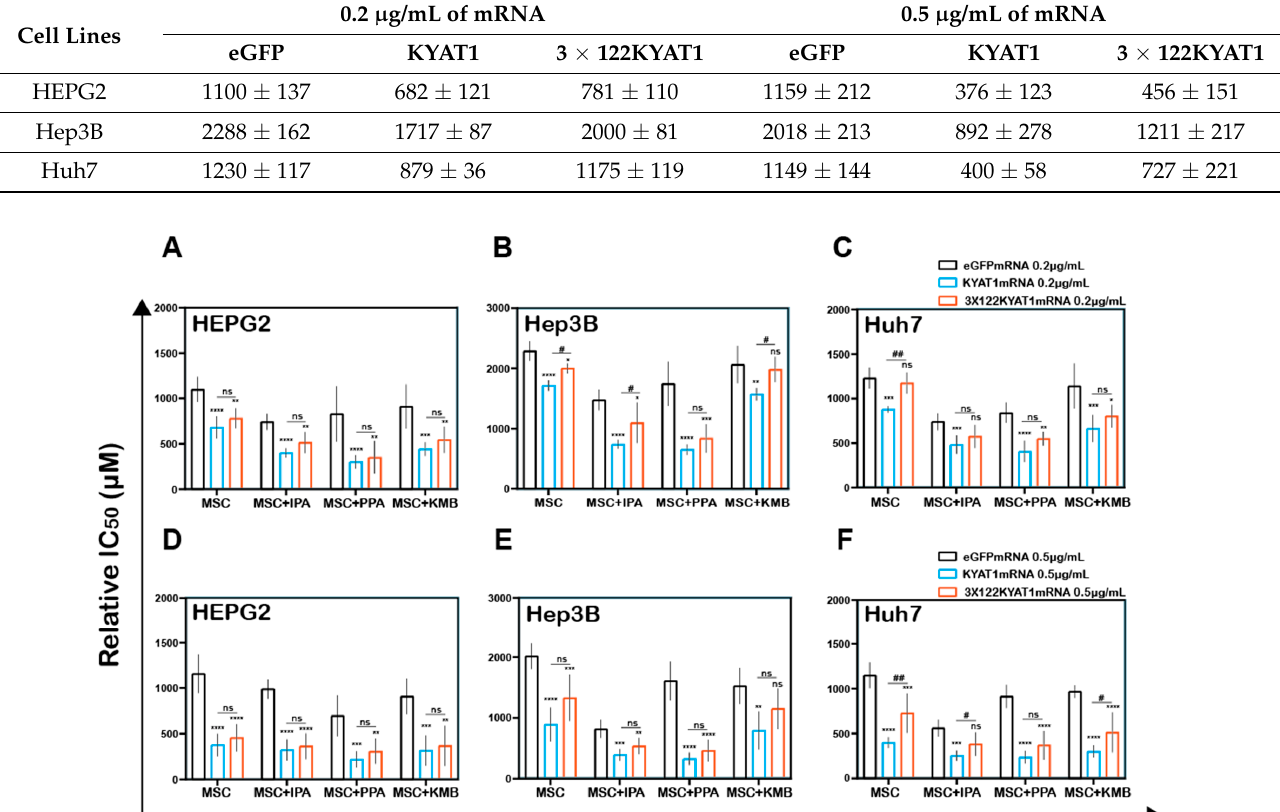
Figure 6. Antisense miR122 target site fusion with KYAT1 alleviates KYAT1 modifiers efficacy with MSC in